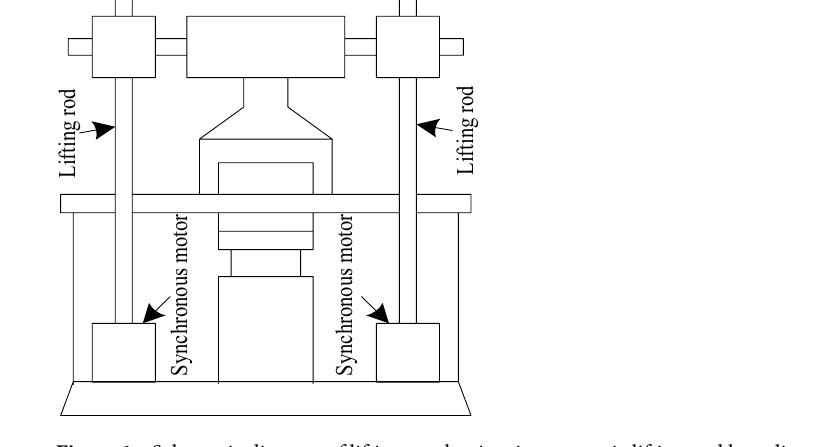
Figure 1. Schematic diagram of lifting mechanism in automatic lifting and boarding equipment of aircraft